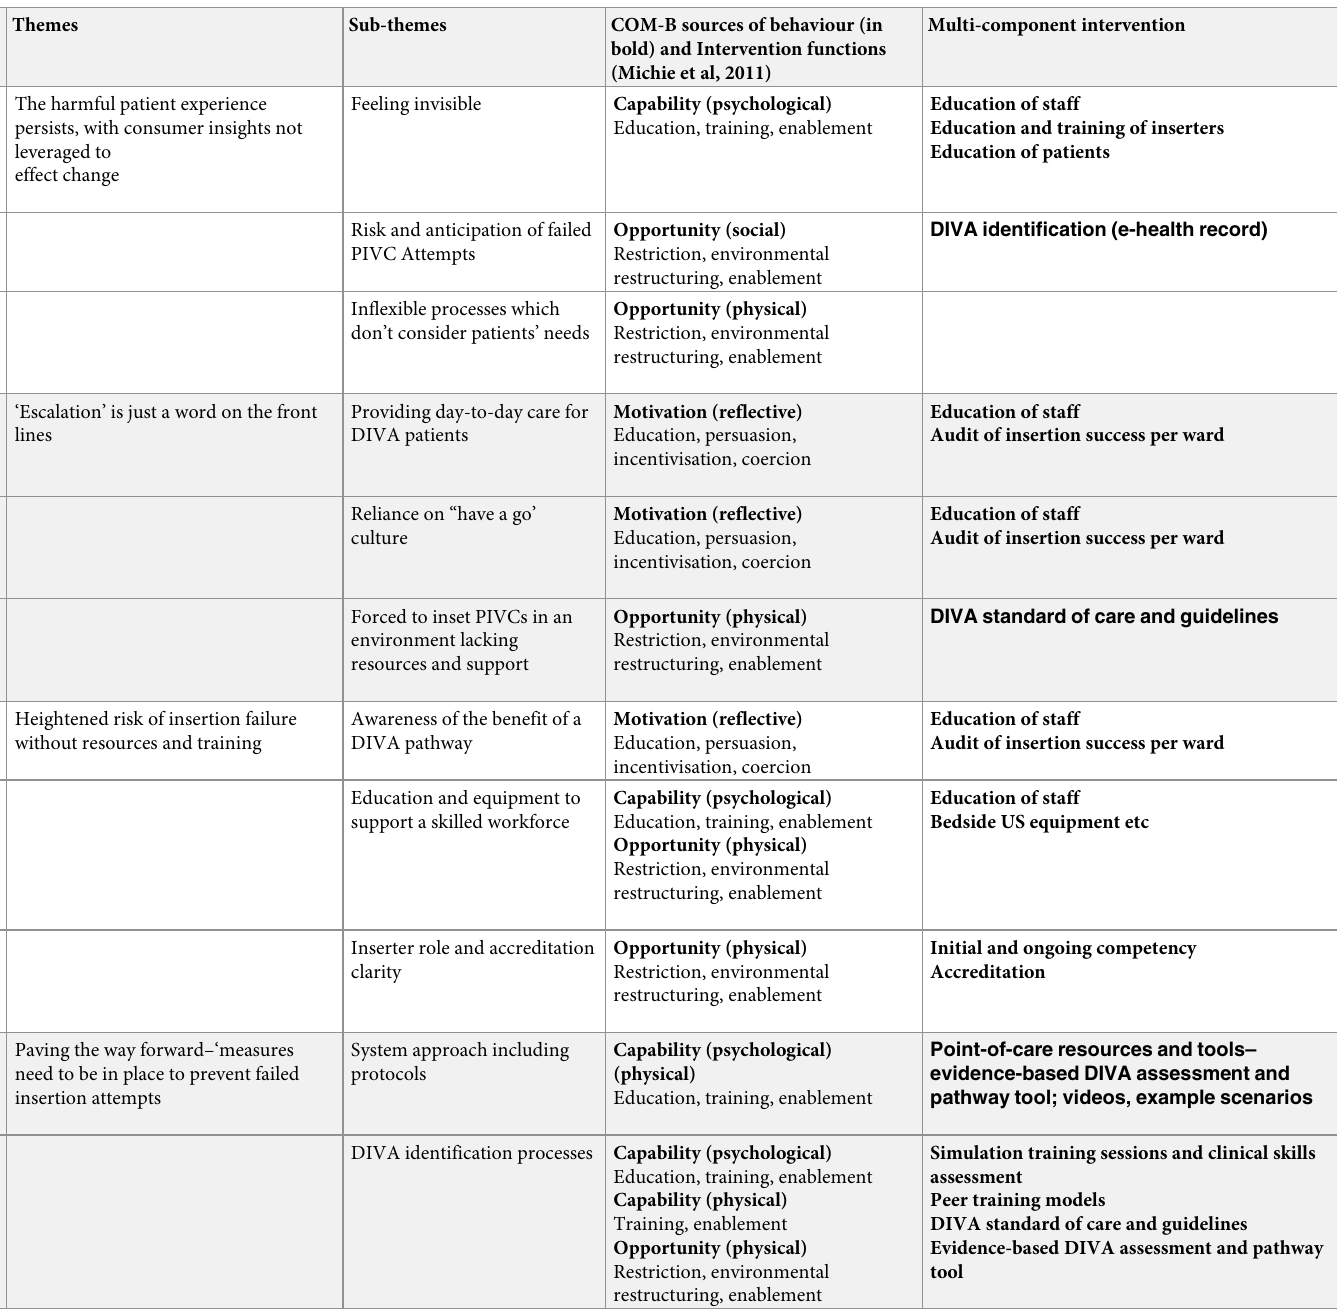
➢ Insert Table 3. Interview themes mapped to COM-B sources of behaviour. Table 3. Interview themes mapped to COM-B sources of